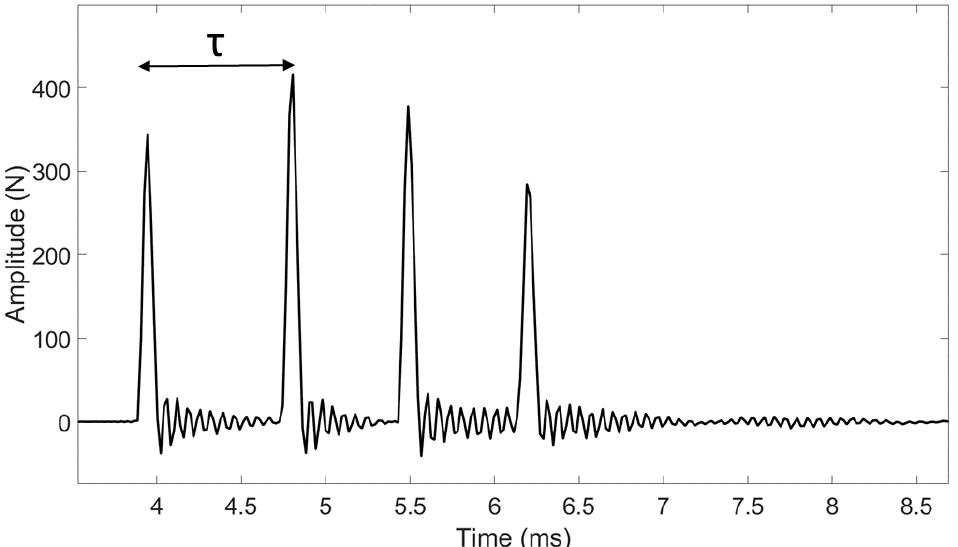
Figure 3. Example of a signal s(t) corresponding to the variation of the force as a function of time obtained for a given impact of the instrumented hammer on the osteotome with a trabecular bone sample.